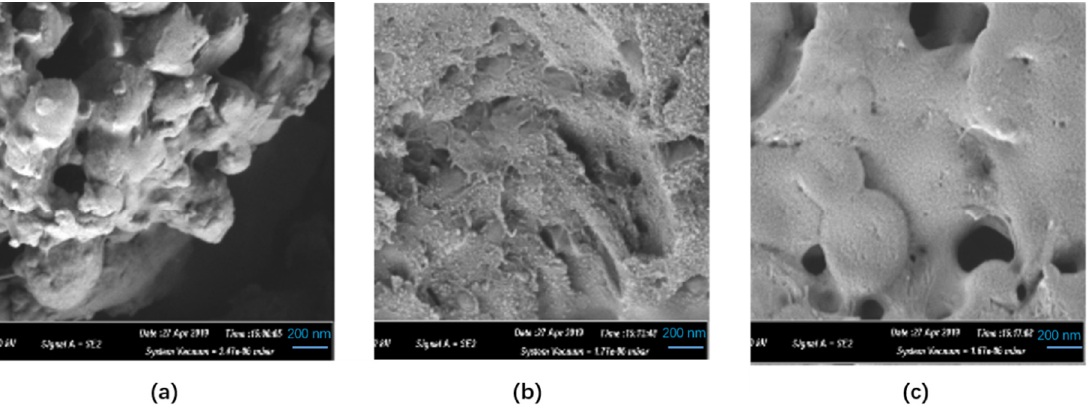
Figure A2. SEM analysis of CLEAs. ( a ) Enzyme + ammonium sulfate (90%) + glutaraldehyde (50 mM); ( b ) Enzyme + ethanol (60%) + glutaraldehyde (20 mM); ( c ) Enzyme + PEG6000 (30%) + glutaraldehyde (15 mM).